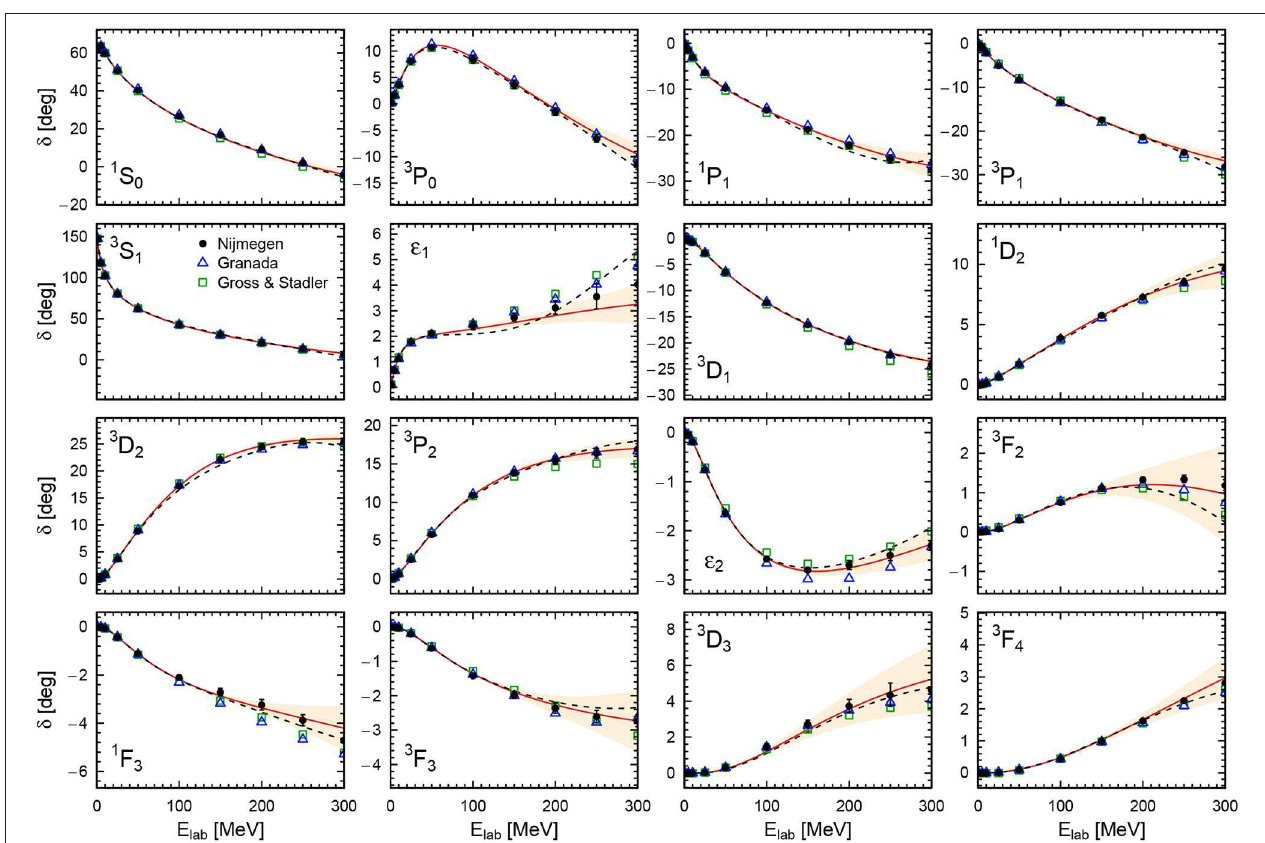
FIGURE 4 | Neutron-proton phase shifts with respect to Riccati-Bessel functions in comparison with the Nijmegen [137] (solid dots), the Granada [149] (blue open triangles), and Gross-Stadler [148] (green open squares) PWA. Red solid lines and peach-colored bands denote the central results and 68% DoB truncation errors at the order N 4 LO + for the cutoff 3 450 MeV. Black dashed lines denote the result of the nonlocal N 4 LO + potential of Entem et al. [ 23] for the cutoff 3 = The shown uncertainties of the Nijmegen PWA correspond to systematic errors defined in Equation (32) of Epelbaum et al. [